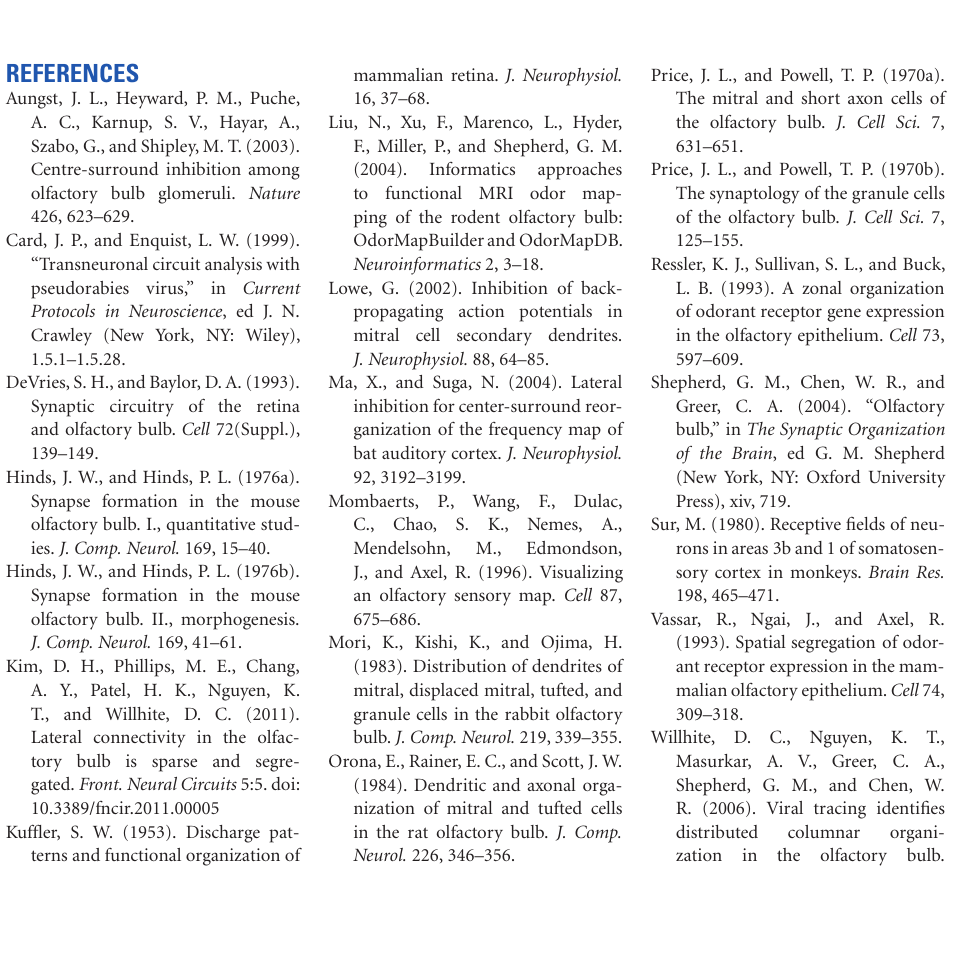
FIGURE 5 | Composite plot. The 22 data-sets were compiled. The shading represents one standard deviation of pixel intensity from the average of the data (red), optimal (black), and mean (purple). The distances at which one standard deviation (68.2%) and two standard deviations (95.4%) of the data are contained are indicated by the dashed vertical